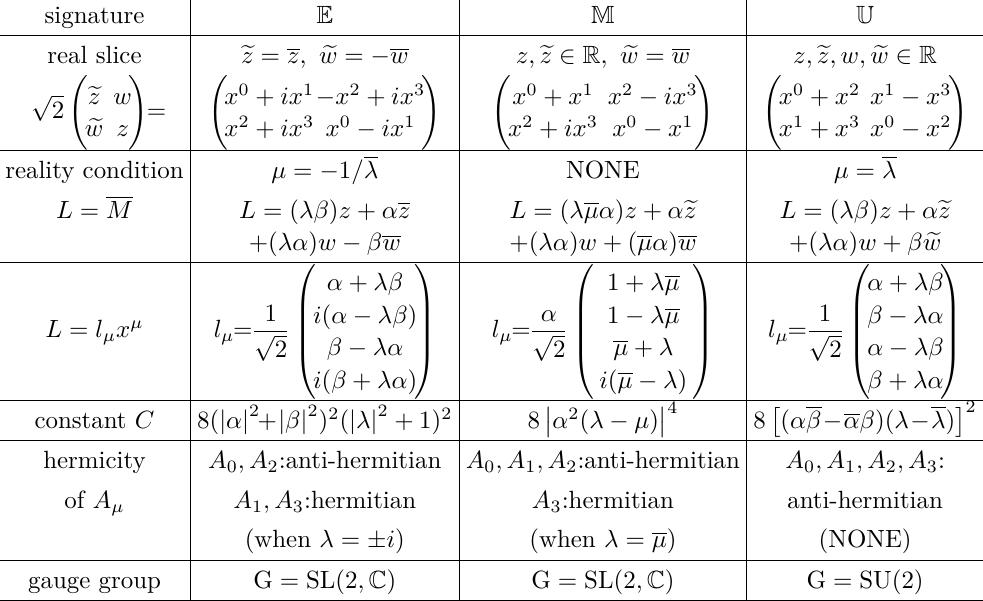
Table 1 . Summary of one-soliton